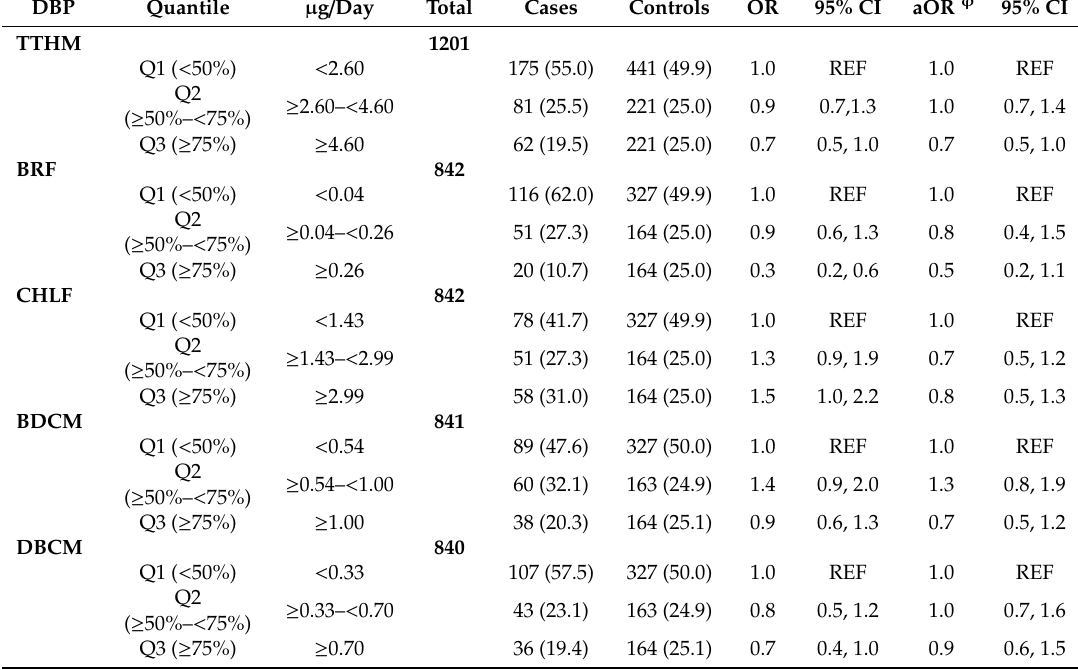
Table 5. Association between hypospadias and maternal uptake of disinfection by-product (DBP)